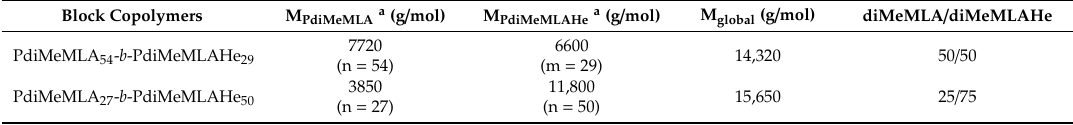
Table 3. Characteristics of PdiMeMLA 54 - b -PdiMeMLAHe 29 and PdiMeMLA 27 - b -PdiMeMLAHe 50 .